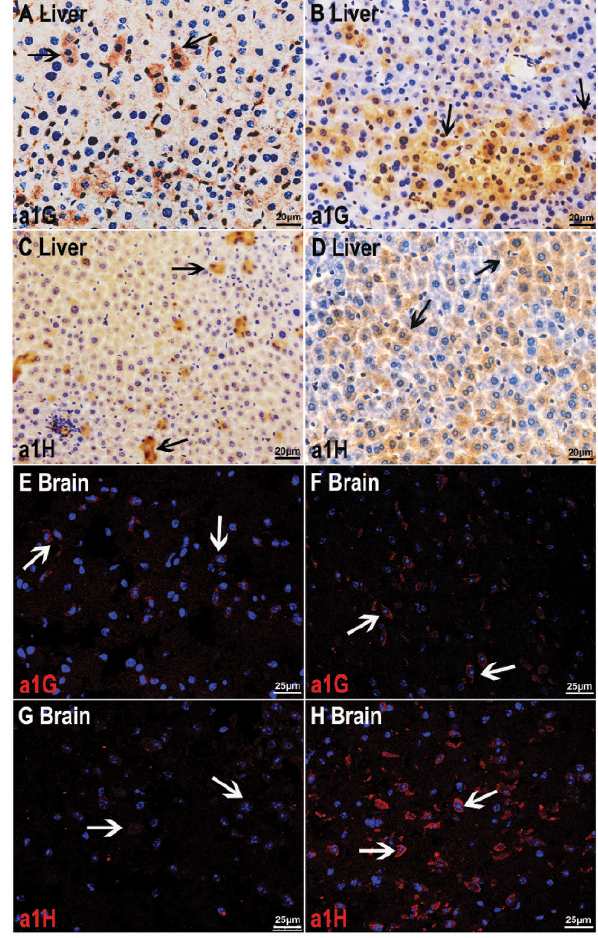
Figure 5 - Immunohistochemical and immunofluorescence stain- ing showing an increased expression of a 1G and a 1H subunits of T-type Ca 2 + channels in liver and brain slide preparations. A and C) Immunohistochemical staining for T-type Ca 2 + channel a 1G (A) and a 1H (C) subunits in liver slide preparations from non-diabetic mice (scale bar=20 m m). B and D) Immunohistochemical staining of db / db animal liver preparations (scale bar=20 m m). E and G) Immunofluorescence staining showing the expression of a 1G (E) and a 1H (G) subunits of T-type Ca 2 + channels in brain slide preparations from nondiabetic mice (scale bar=25 m m). F and H) Immunofluorescence staining of brain slide preparations from db / db mice (scale bar=25 m